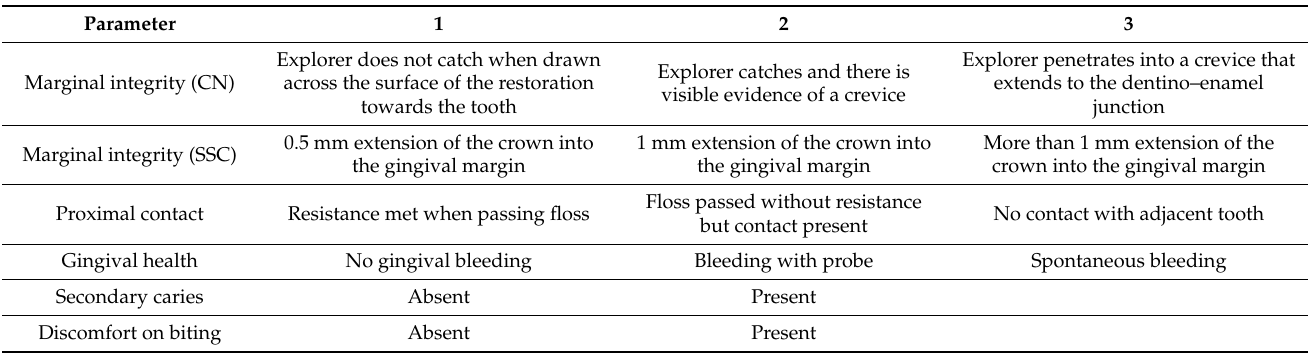
Table 1. Scoring criteria for the parameters for clinical evaluation of